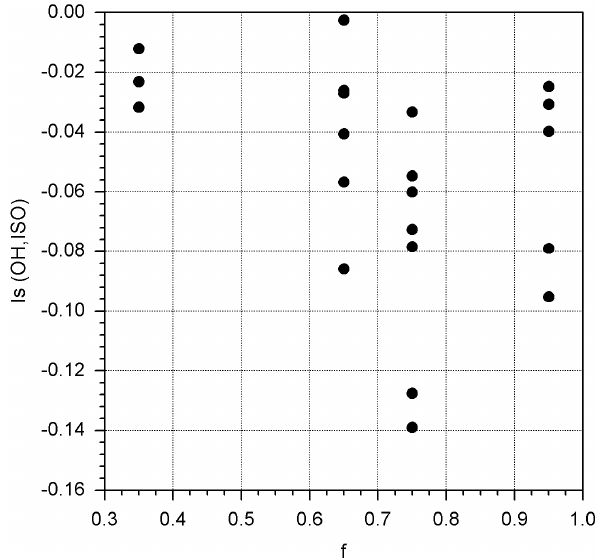
Figure 5. The intensity of segregation I S as a function of factor f from Eq. (4) with data from Tables 1 and